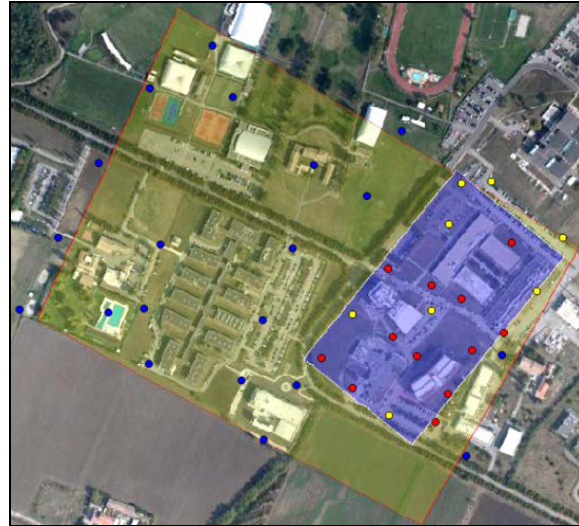
Figure 1: The area used for the case studies. In light yellow the 140 m high flight zone, in blue the 70 m flight zone. Yellow, blue and red dots show the GCPs used respectively for both case studies, only for the 140 m flight and only for the 70 m flight.